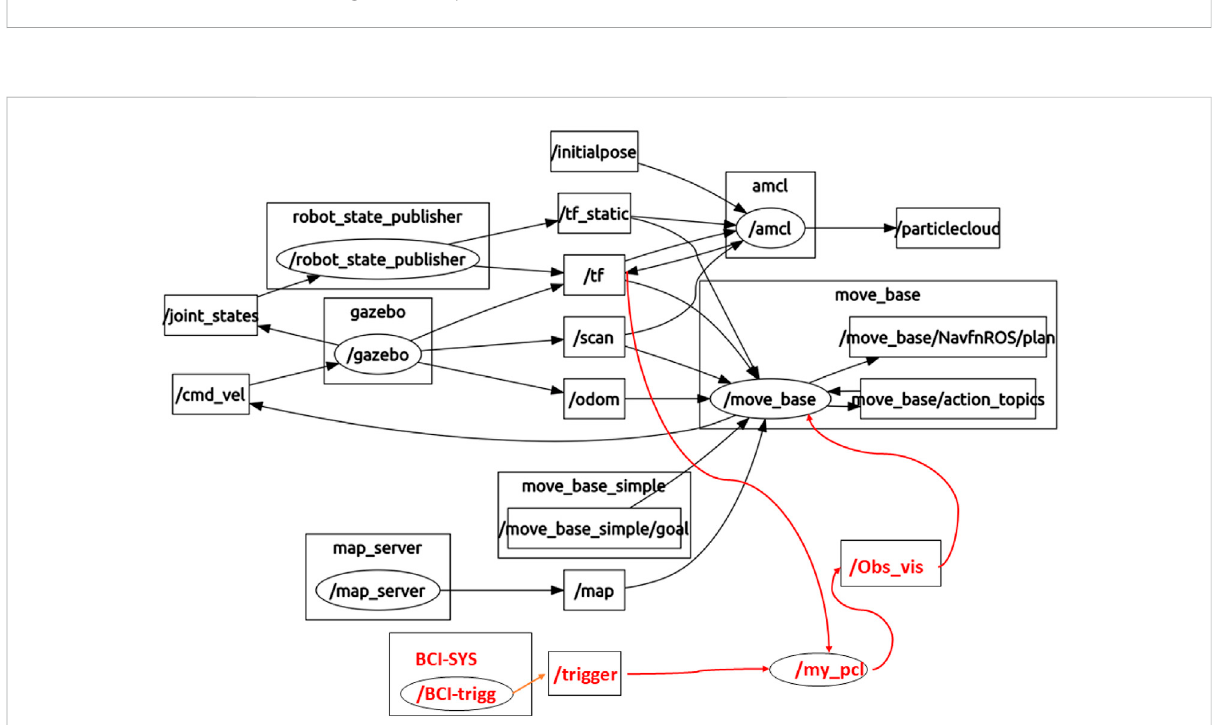
FIGURE 3 ROS packages and nodes that communicate through topics to exchange